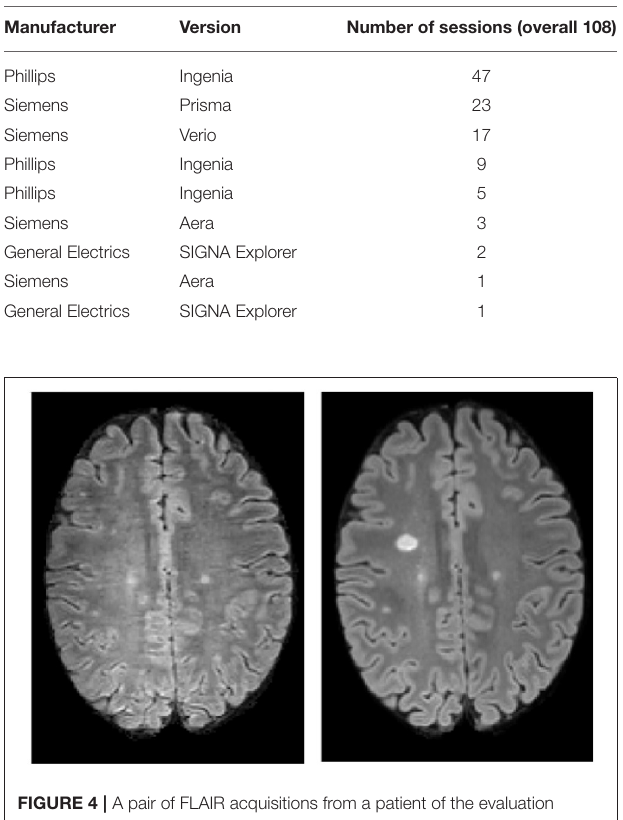
TABLE 1 | Repartition of patients in the different scanners (each row is a different scanner).